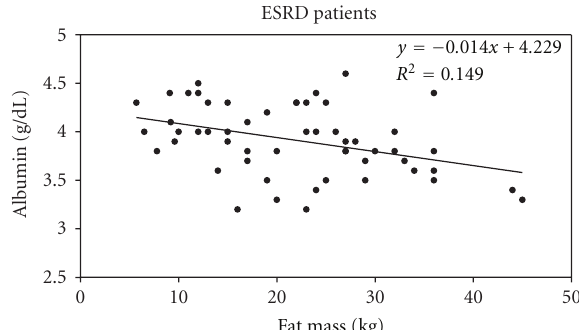
Figure 7: Negative relationship between Albumin circulating levels and Fat Mass. The Albumin circulating levels and Fat Mass were measured in 54 inflamed ESRD (End-Stage Renal Disease) patients. Correlation is significant at the 0.01 level (2-tailed). R = − 0 . 391.